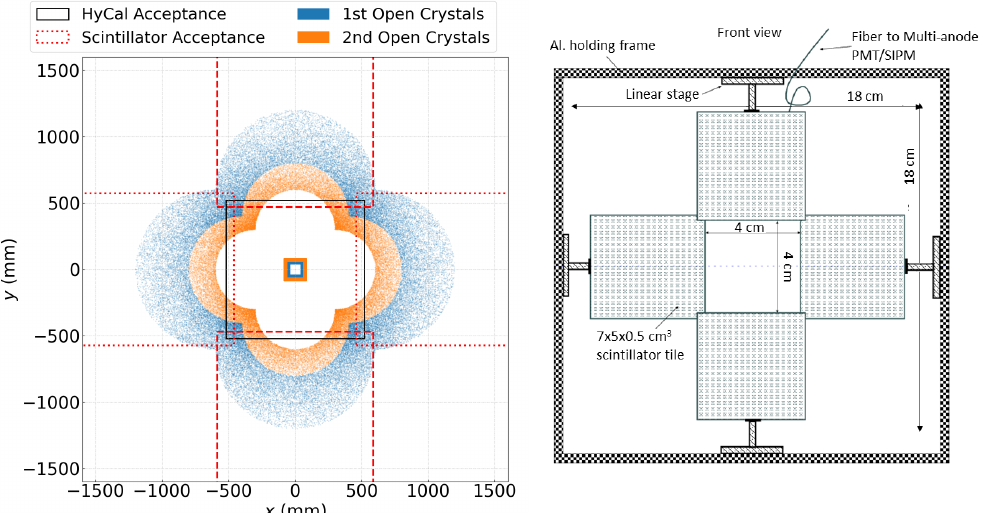
Figure 11. Left panel: The distribution of Møller electrons, when the other one is detected by the two opened innermost layers of HyCal. Red dash lines show the boundaries of the scintillator tiles. Right panel: A schematic view of the scintillator detector to enhance detection of the Møller electrons. Figure credit: A. Gasparian et al.